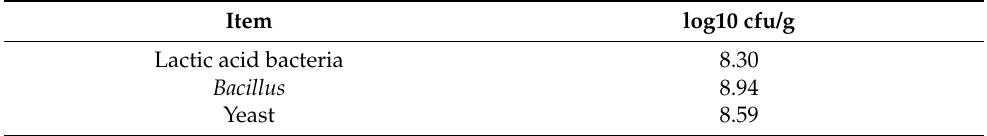
Table 3. The actual microbial counts of the additives before being fed to the animals.